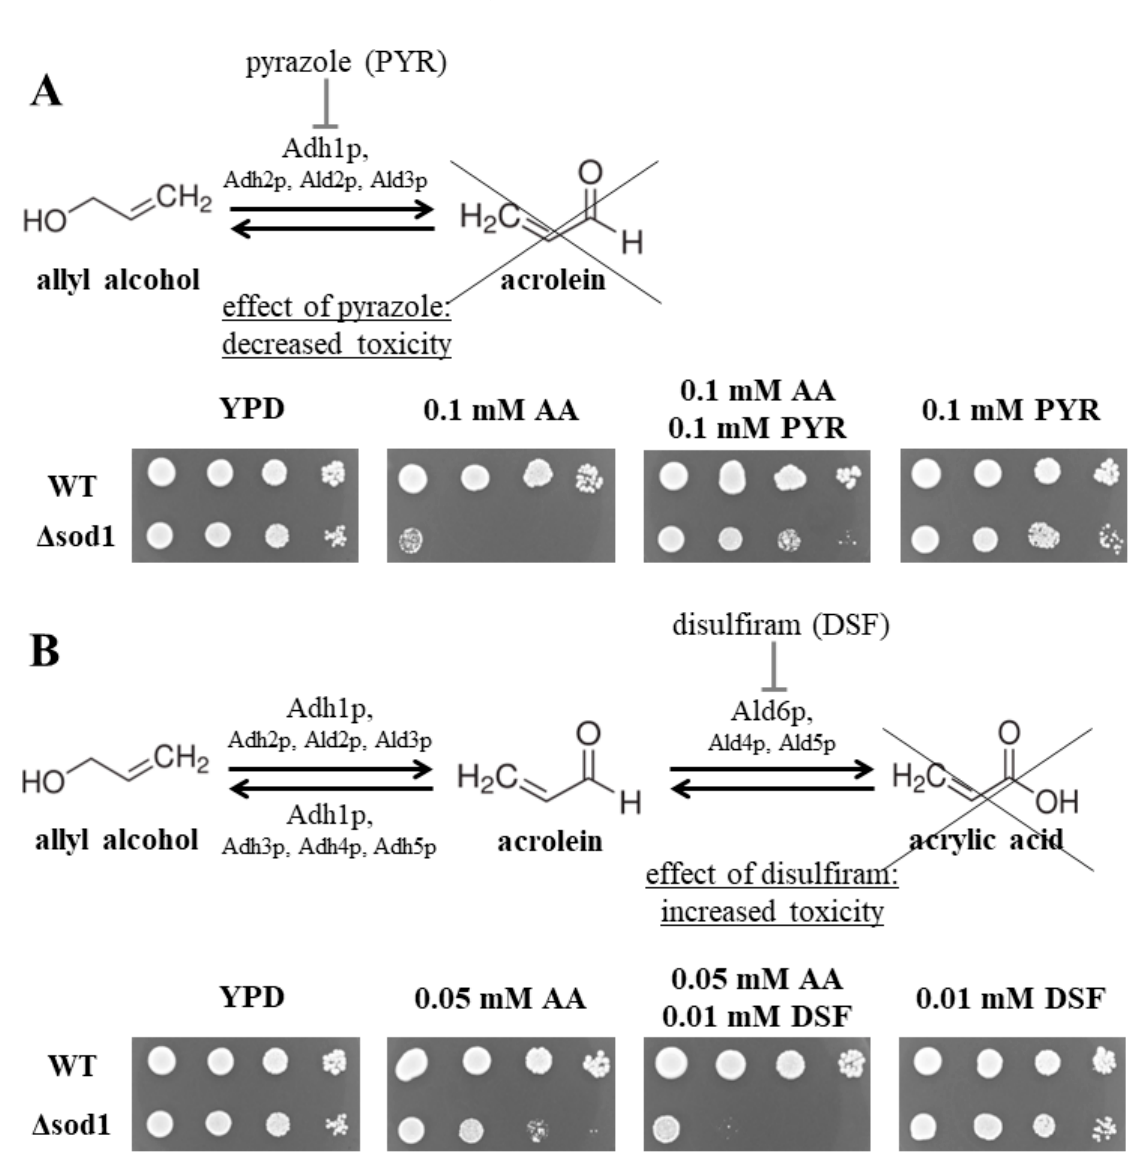
Figure 1. Metabolism of allyl alcohol (AA) and acrolein (Acr) in the Saccharomyces cerevisiae yeast. The wild-type (WT) strain and Δ sod1 mutant were cultivated in the YPD liquid medium for 16 h, diluted serially (1:10), and suspensions were spotted onto solid YPD plates containing allyl alcohol (0.05- or 0.1 mM AA) and 0.1 mM pyrazole (PYR) ( A ) or 0.01 mM disulfiram (DSF) ( B ). Successive spots contained 50,000, 5000, 500, and 50 cells. Plates were cultivated at 28 °C and colony growth was recorded after 48 h.